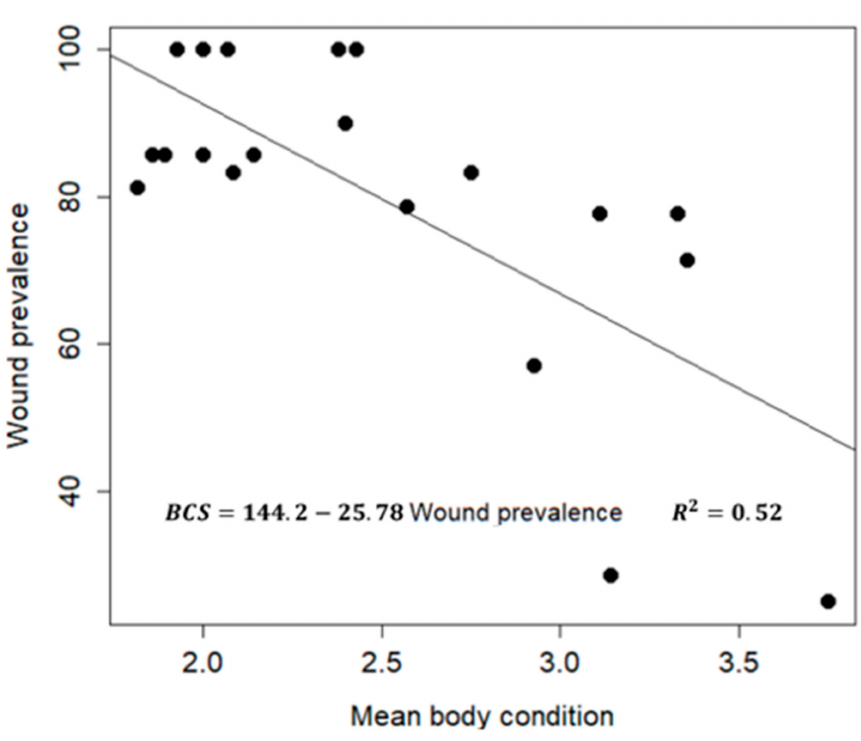
Figure 6. A scatter plot of the mean body condition and wound prevalence (%) in the 20 brick kilns selected, along with a regression